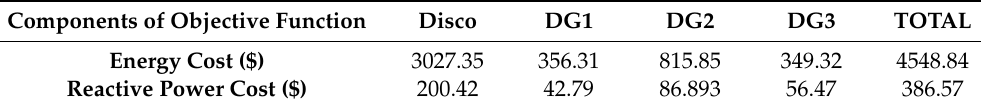
Table 7. Optimization results of the joint active/reactive power dispatch in Scenario 2.